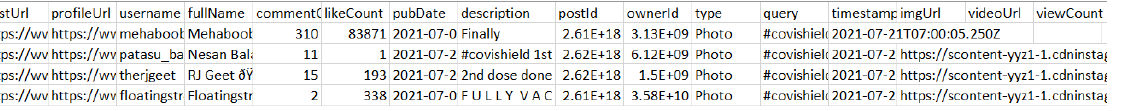
Figure 4. The #covaxin post metadata with additional details such as the URL, likeCount, viewCount, and others.